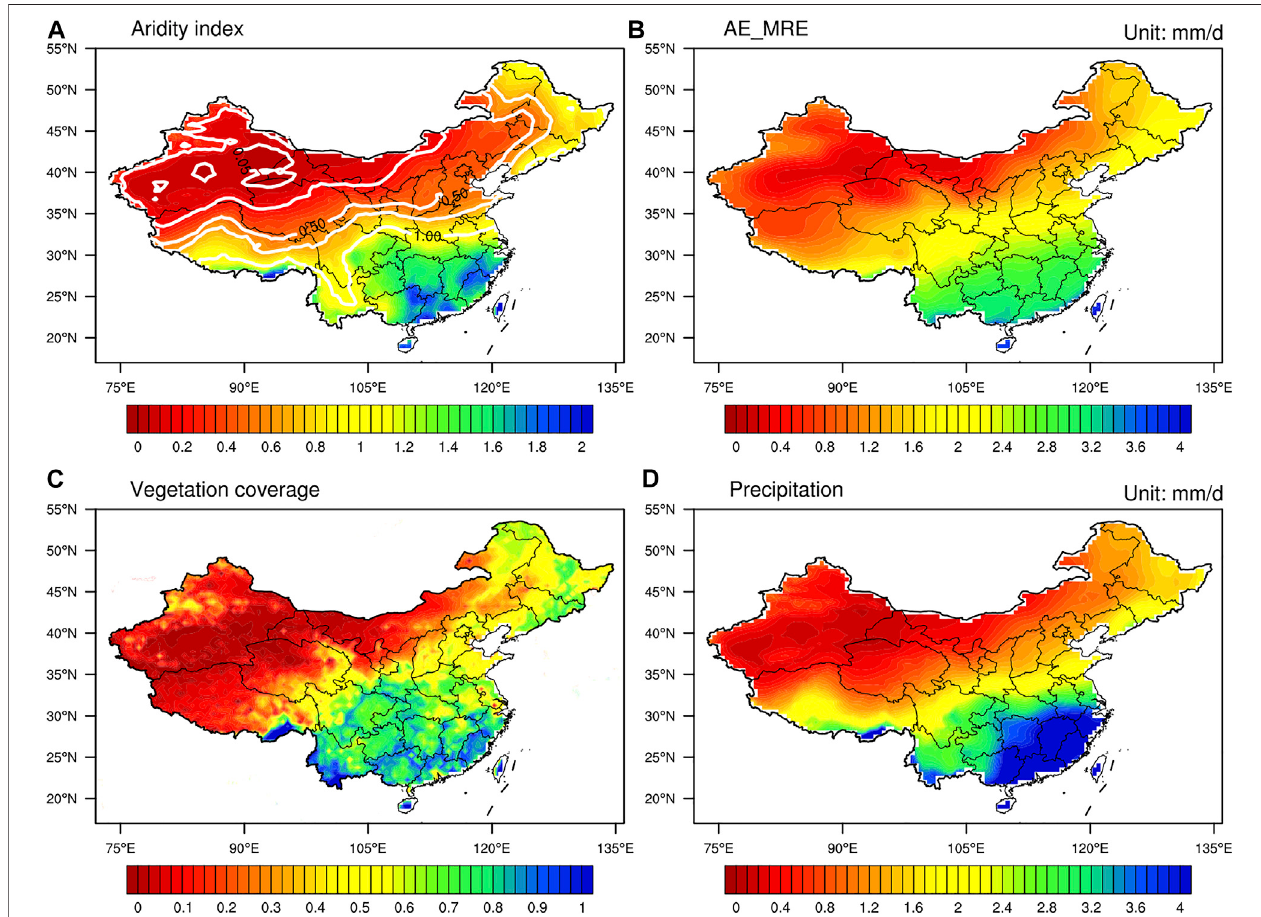
FIGURE 1 | The climatological distribution of (A) aridity index, (B) annual mean actual evapotranspiration (AE_MRE; mm d − 1 ) derived from the average of six reanalyses, (C) vegetation cover, and (D) annual mean precipitation (mm d − 1 ) for 1982 – 2015.